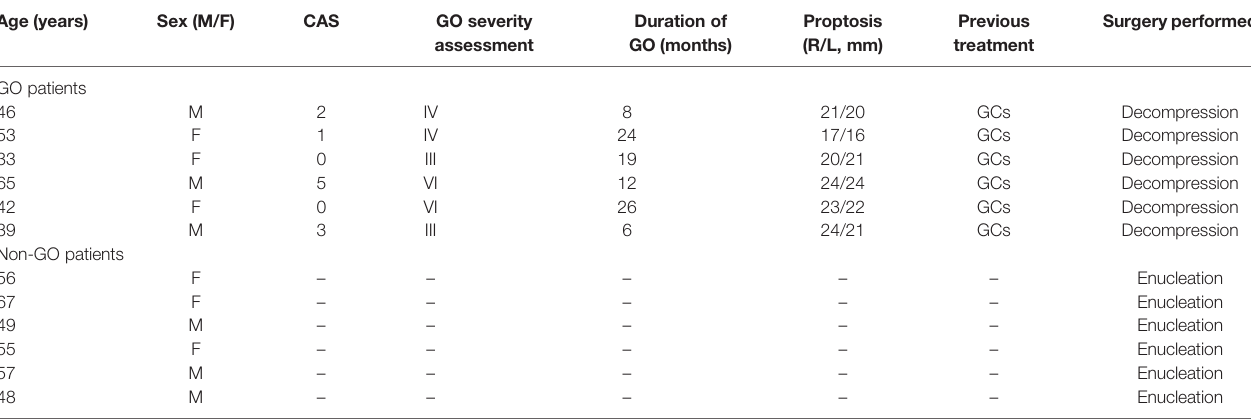
TABLE 1 | Clinical features of patients samples included in this